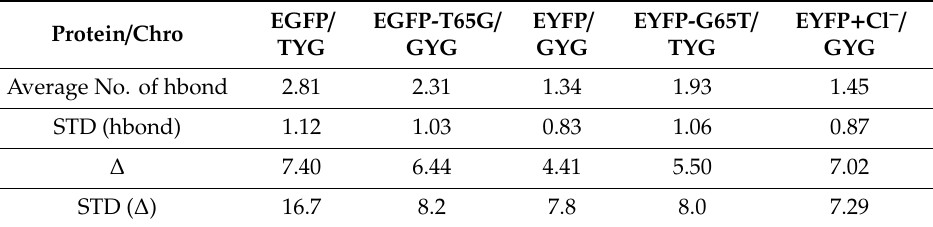
Table 2. Average number of hydrogen bonds (and standard deviation) formed within 6 Å around the chromophore computed along the equilibrium ground-state trajectories. Distance and angle cuto ff s were set to 3.2 Å and 20 ◦ , respectively. Deviation of the chromophore from planarity ( ∆ , in degrees) is also shown. EGFP / EGFP-T65G / EYFP / EYFP-G65T / EYFP + Cl – / Protein / Chro TYG GYG GYG TYG GYG Average No. of hbond 2.81 2.31 1.34 1.93 1.45 STD (hbond) 1.12 1.03